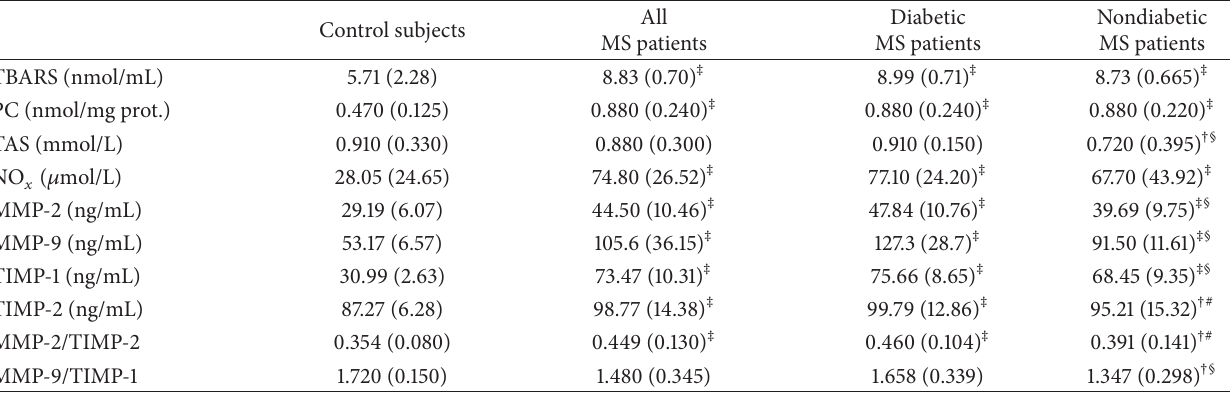
Table 2: Medians (interquartile ranges) of gelatinase and inhibitor plasma concentrations in normal controls, in the whole group of MS patients, and in the two subgroups, respectively, with and without diabetes